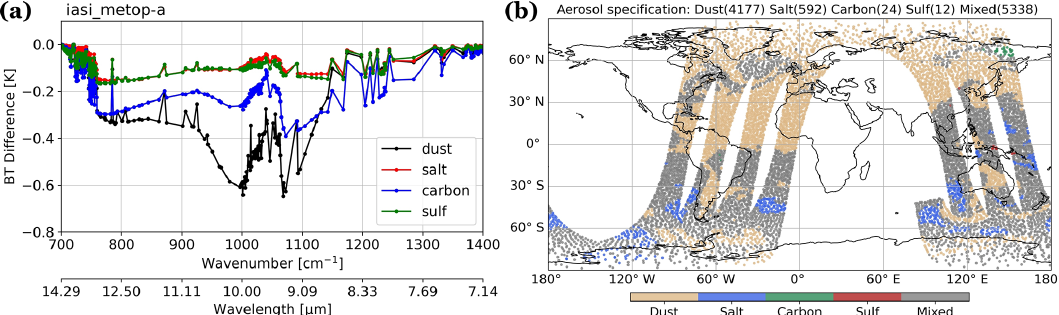
Figure 2. (a) The differences (AER − CTL) of first-guess brightness temperatures in the IR window region of IASI on board METOP-A. (b) The corresponding regions dominated by different aerosol species at 12:00Z on 22 June 2020. The data counts for each species are labeled in panel (b) . Table 3. The range of aerosol column mass density (kgm − 2 ) from MERRA-2 at the regions dominated by different aerosol species (fraction over 0.65) of IASI on board METOP-A at the cycle of 12:00Z on 22 June 2020. Dominant aerosol